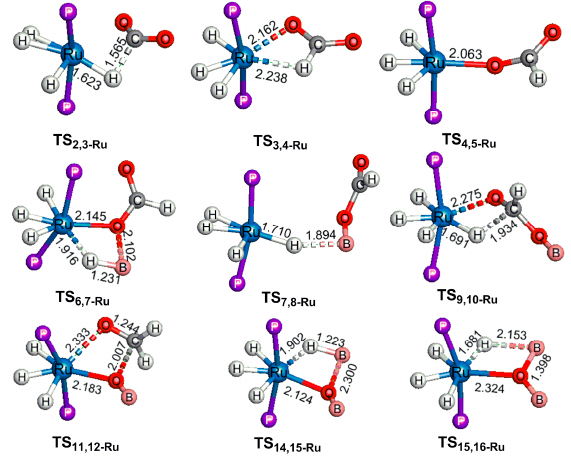
Figure 2. Optimized structures of TS 2,3 ‐ Ru (513 i cm − 1 ), TS 3,4 ‐ Ru (170 i cm − 1 ), TS 4,5 ‐ Ru (176 i cm − 1 ), TS 6,7 ‐ Ru (127 i cm − 1 ), TS 7,8 ‐ Ru (209 i cm − 1 ), TS 9,10 ‐ Ru (363 i cm − 1 ), TS 11,12 ‐ Ru (159 i cm − 1 ), TS 14,15 ‐ Ru (67 i cm − 1 ) and TS 15,16 ‐ Ru (97 i cm − 1 ). Bond lengths are in Å. The cyclopentyl and pinacol groups are not shown for clarity.